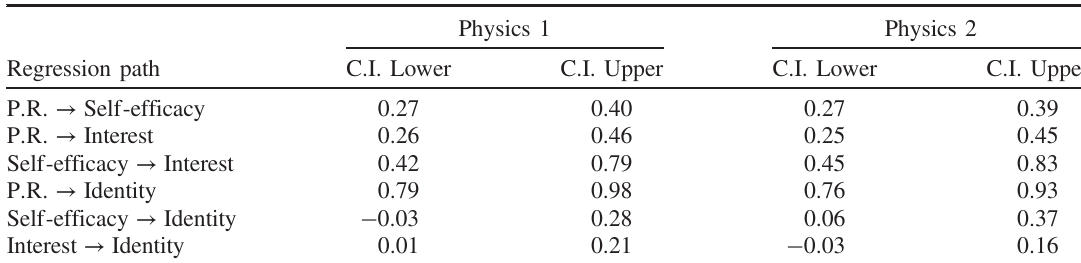
TABLE V. Confidence intervals for each regression pathway in physics 1 and physics 2. C.I. is the confidence interval, P.R. is perceived recognition, Lower is lower bound and Upper is the upper bound. The proportion of overlap is above 0.5 for each of the regression pathway confidence intervals, and thus the regression pathways are not statistically significantly different from one